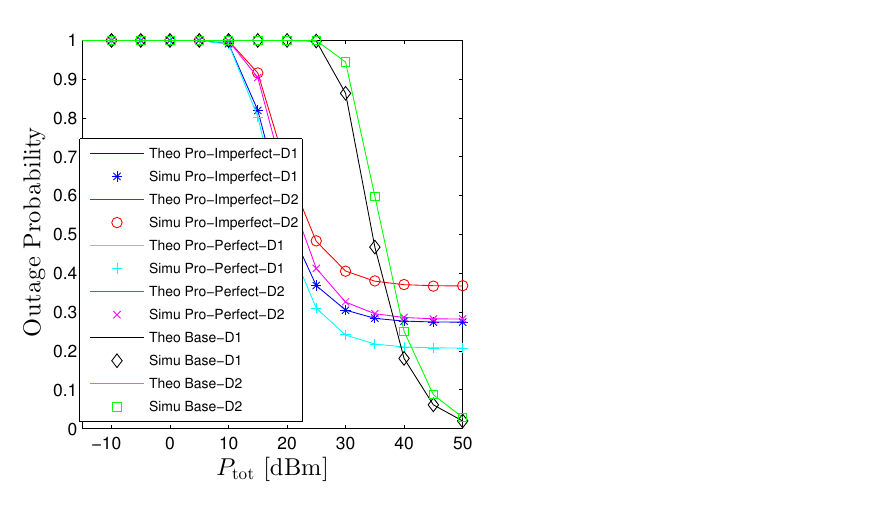
Figure 4. Outage probability vs. P tot under all schemes. Solid lines are plotted by employing (15)–(17) while markers are Monte Carlo simulation.